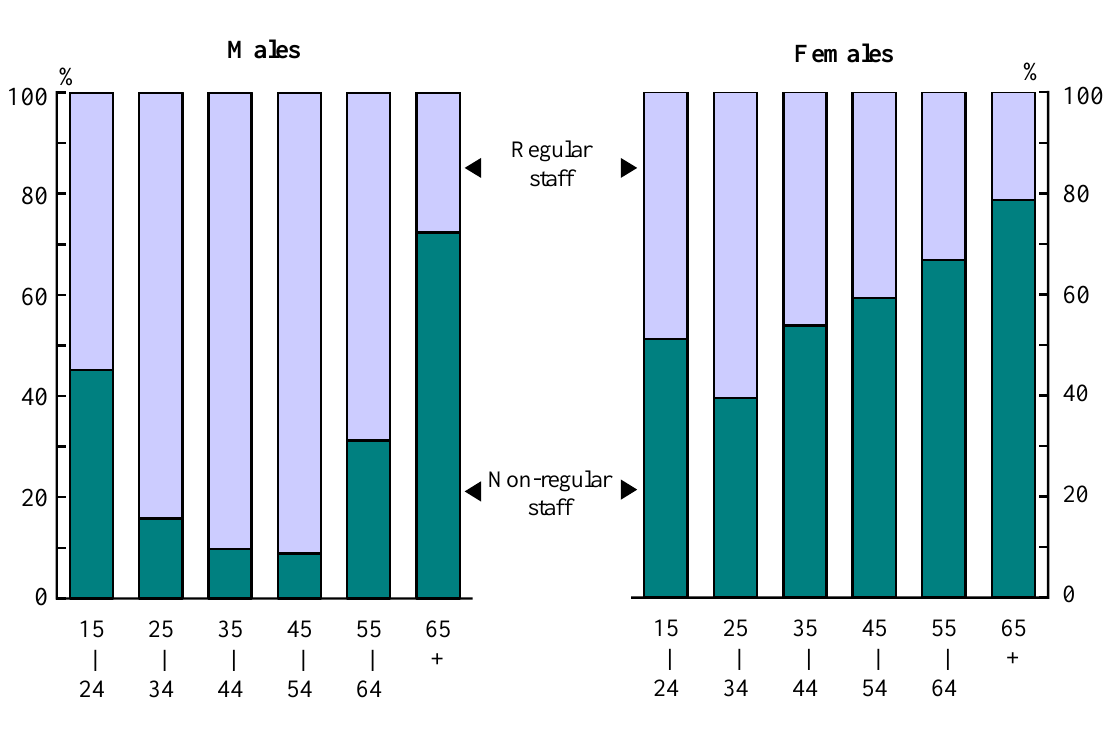
Employment Pattern by Gender and Age (2016)